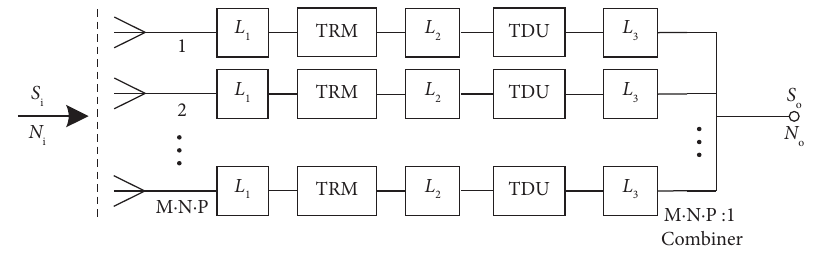
Figure 5: Block diagram of a one-stage combiner